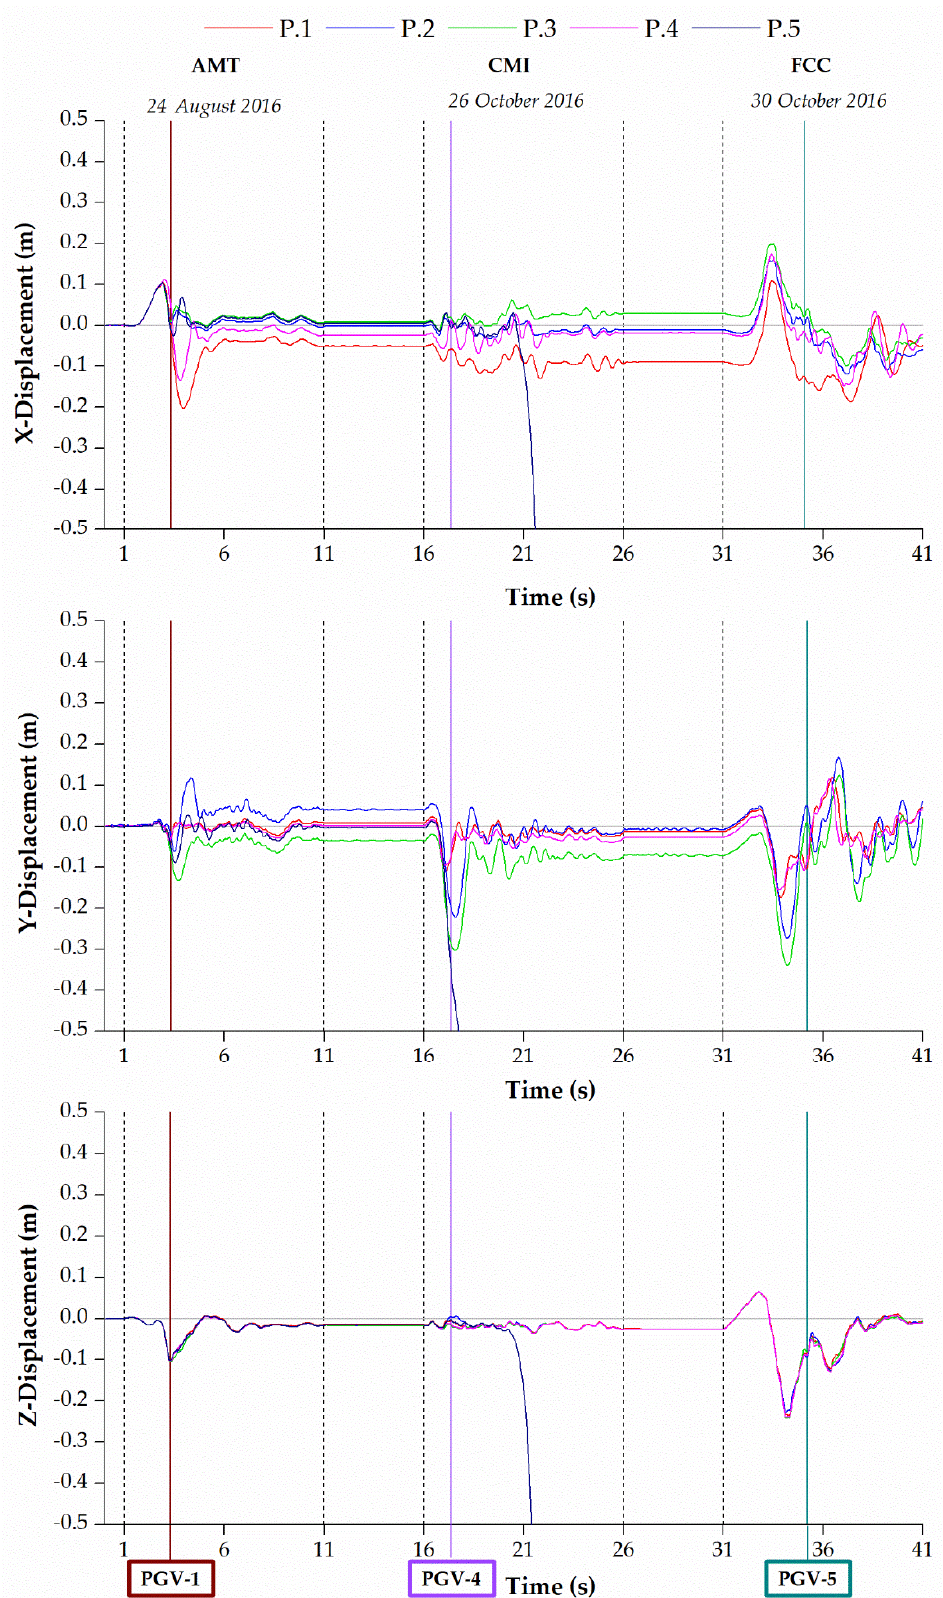
Figure 15. Displacements THs in the x, y, and z directions of the five church monitoring points calculated with nonlinear dynamic analyses by means of the NSCD method under the epicentral seismic actions.